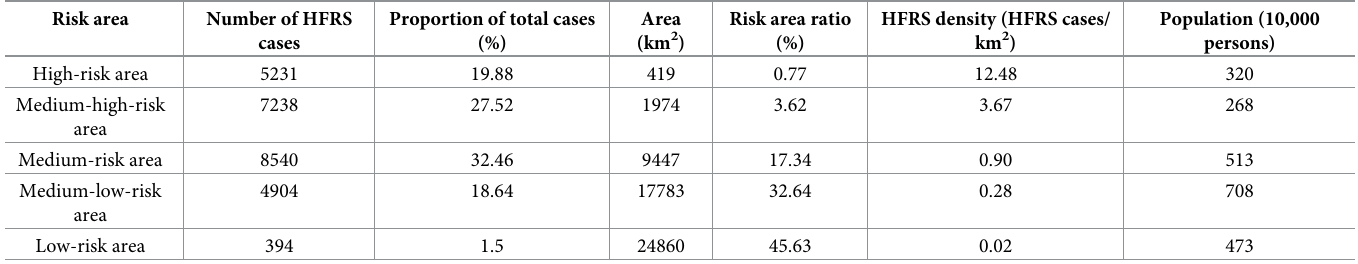
Table 4. The correspondence between the number of HFRS cases and the level of risk zoning in Weihe Basin. Risk